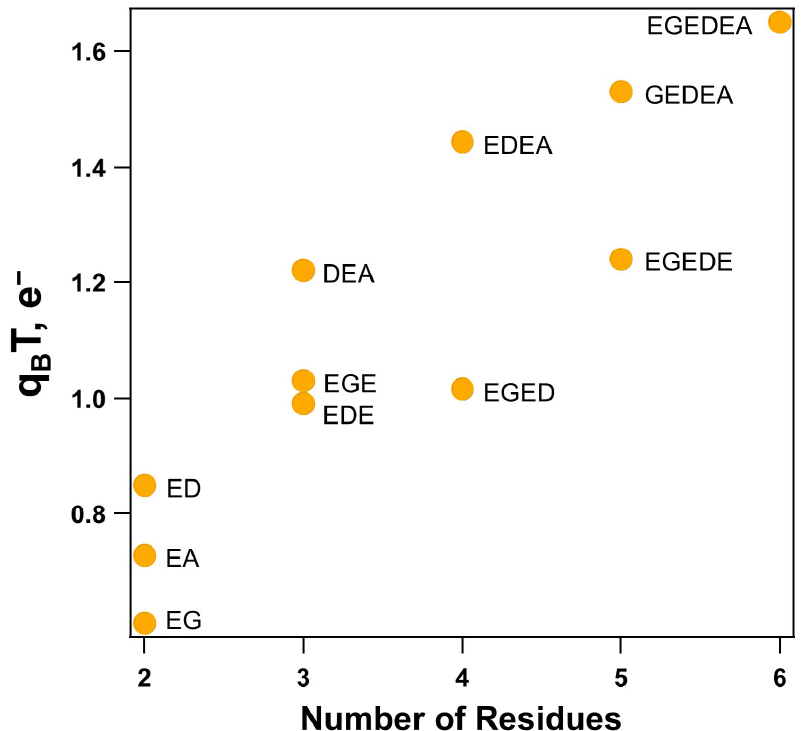
Figure 4. Correlation of the computed Boltzmann-weighted sum of the total magnitude of the intramolecular charge transfer, q B T, as the size, n , of the peptide chain increases from n = 2 to n = 6, presented in millielectrons, e −